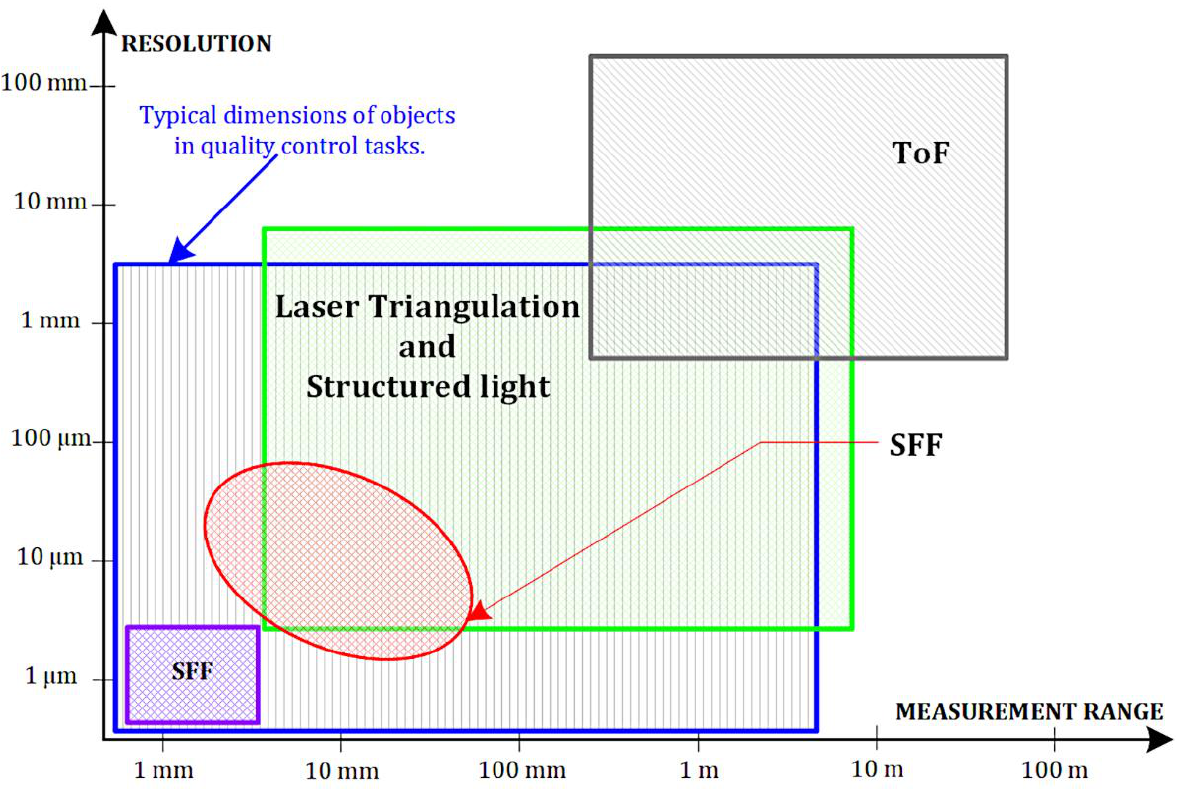
Figure 6. Resolution in 3D imaging